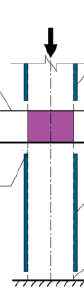
Figure 2. Schematic diagram of a beam – STCC column joint.